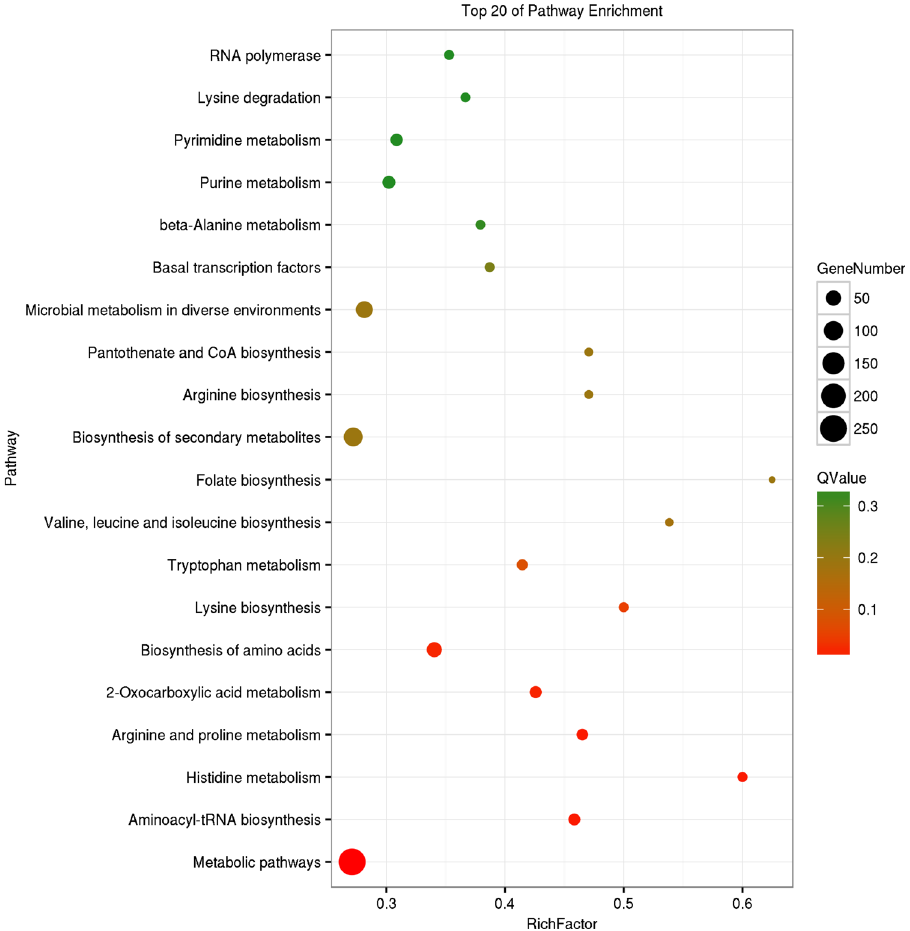
Figure 4. KEGG enrichment diagrams of gene of module blue. Vertical axis represents pathway entries, and Rich Factor on the horizontal axis refers to the ratio of the number of genes of DEGs in the pathway to the total number of genes of all genes in the pathway. The higher the Rich Factor value is, the higher enrichment degree is. Size of the circle corresponds to the number of enriched genes, and the larger the circle, the more genes there are. QValue is the p -value after multiple hypothesis test correction, which ranges from 0 to 1, corresponding to the gradual change of red to green. The closer it is to zero, the more red it is, and the more significant the enrichment is. This figure is plotted with the first 20 pathway of QValue of from smallest to